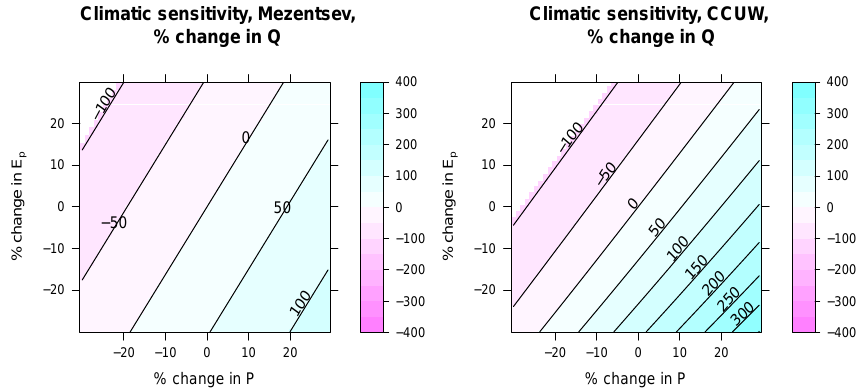
Fig. 8. Sensitivity plots of streamflow to percent changes of precipitation and E p , estimated for the long term hydro-climatic states of the Murray-Darling Basin (as given in Table 1). Contour lines depict the percent change in streamflow. Note that changes of 1Q/Q smaller than − 100% are not physical. Left panel: The Budyko framework using the Mezentsev function and Eq. (22) in accordance to Roderick and Farquhar (2011, Fig. 2). Right panel, sensitivity estimation by the CCUW framework Eq.